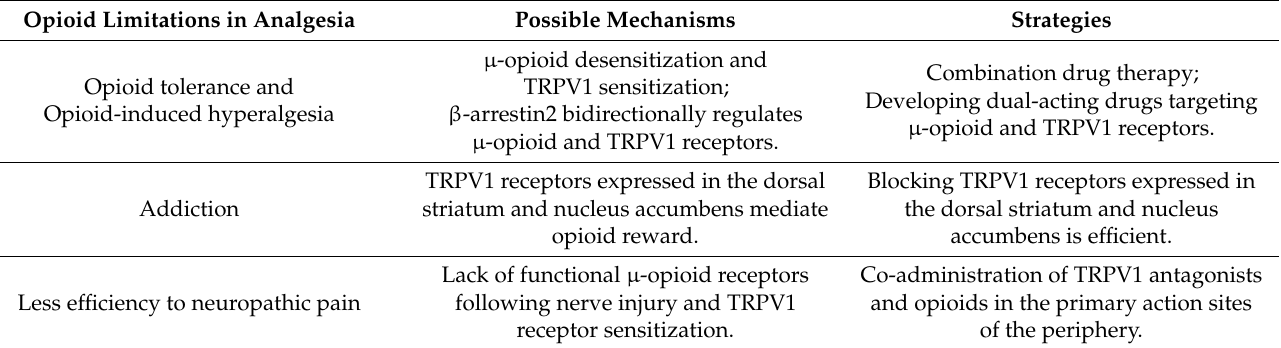
Table 1. The possible mechanisms and therapeutic strategies to alleviate opioid side effects via regulating